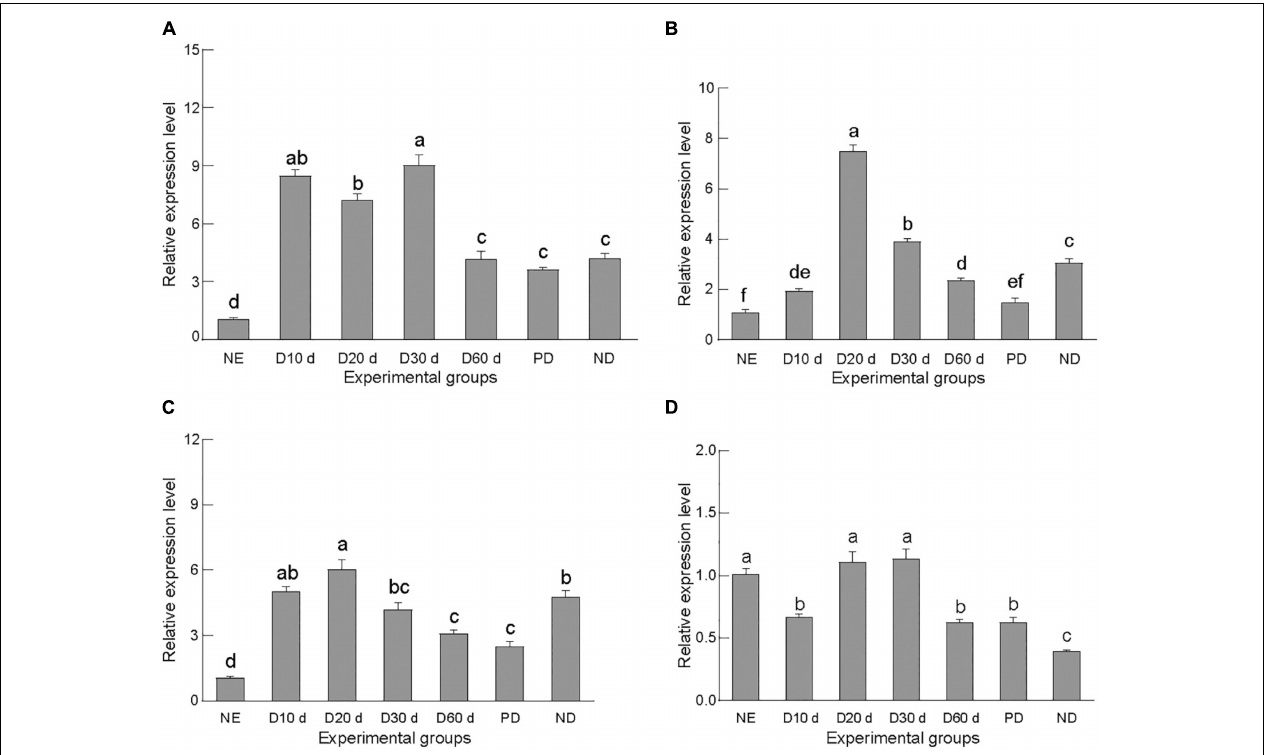
FIGURE 2 | Relative gene expression of CsACC (A) , CsACSL (B) , CsELO (C) , and CsKAR (D) . NE, newly emerged adults; D10d, delayed induction for 10 days; D20d, delayed induction for 20 days; D30d, delayed induction for 30 days; D60d, delayed induction for 60 days; PD, post-diapause; ND, normal development. Data are presented as mean ± SE. Significance analyses were performed using Tukey’s post-hoc test. Different letters indicate a significant difference between stages ( P <